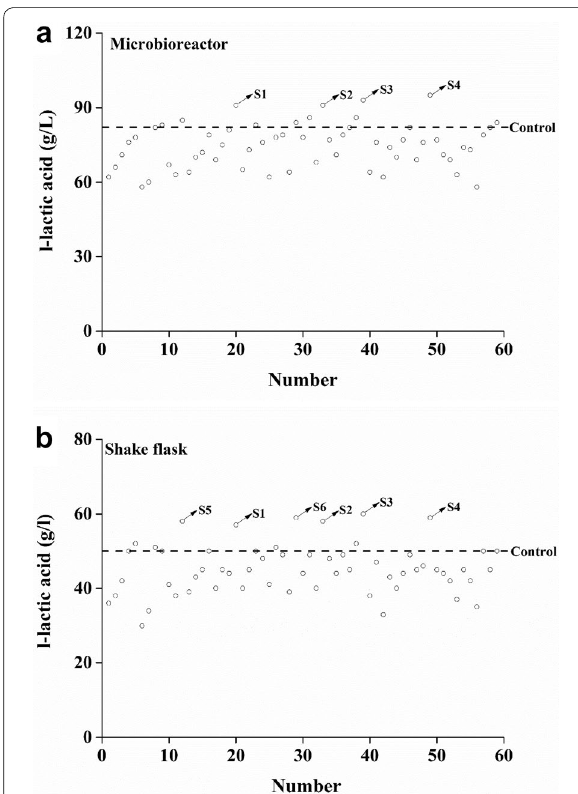
Fig. 8 Comparison of l -lactic acid production with mutant strains ( L. paracasei S1 to S6) and the parent strain ( L. paracasei NCBIO01) in the shake flask and micro-bioreactor rescreening